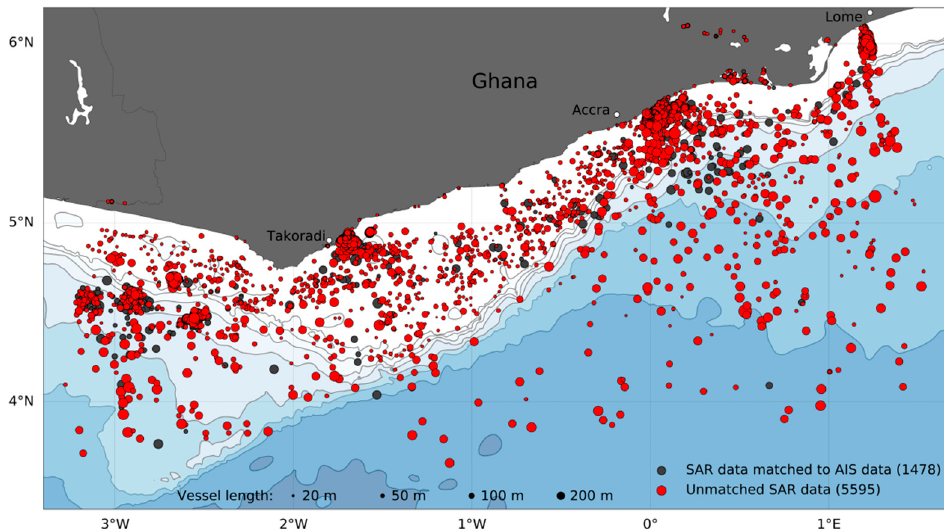
Figure 16. The number of vessels recorded in SAR matched to AIS versus those that exist in the SAR record but have no AIS counterpart. Over 75% of the SAR detected vessels are not AIS registered. The size of each point corresponds to its detected size in either the SAR record, or as reported by the AIS transponder at the time of SAR sensor overpass.